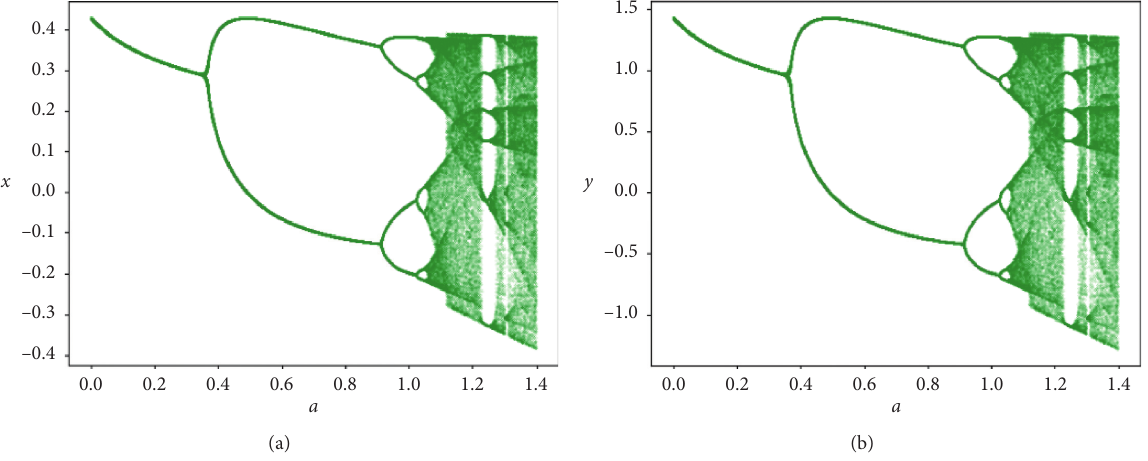
Figure 5: The bifurcation diagram of Henon. (a) a − x and (b) a − y .